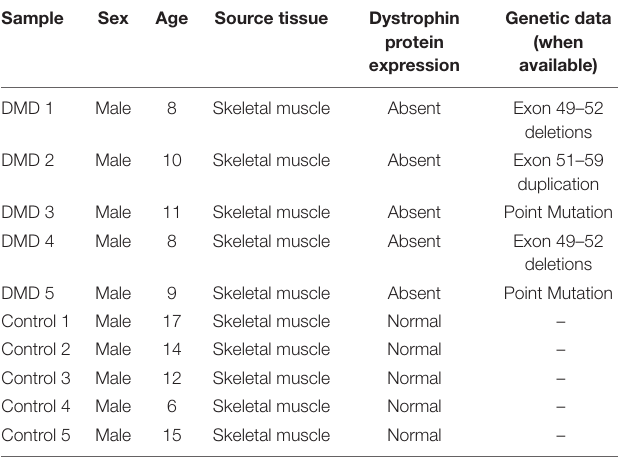
TABLE 2 | Clinical background information of the human participants.